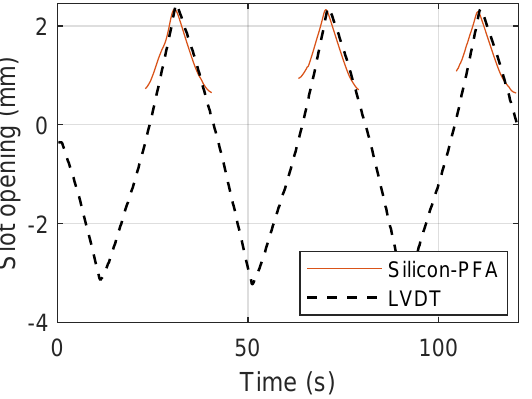
Figure 24. Comparison of fiber-optic and LVDT measurements of slot opening at a drift level of